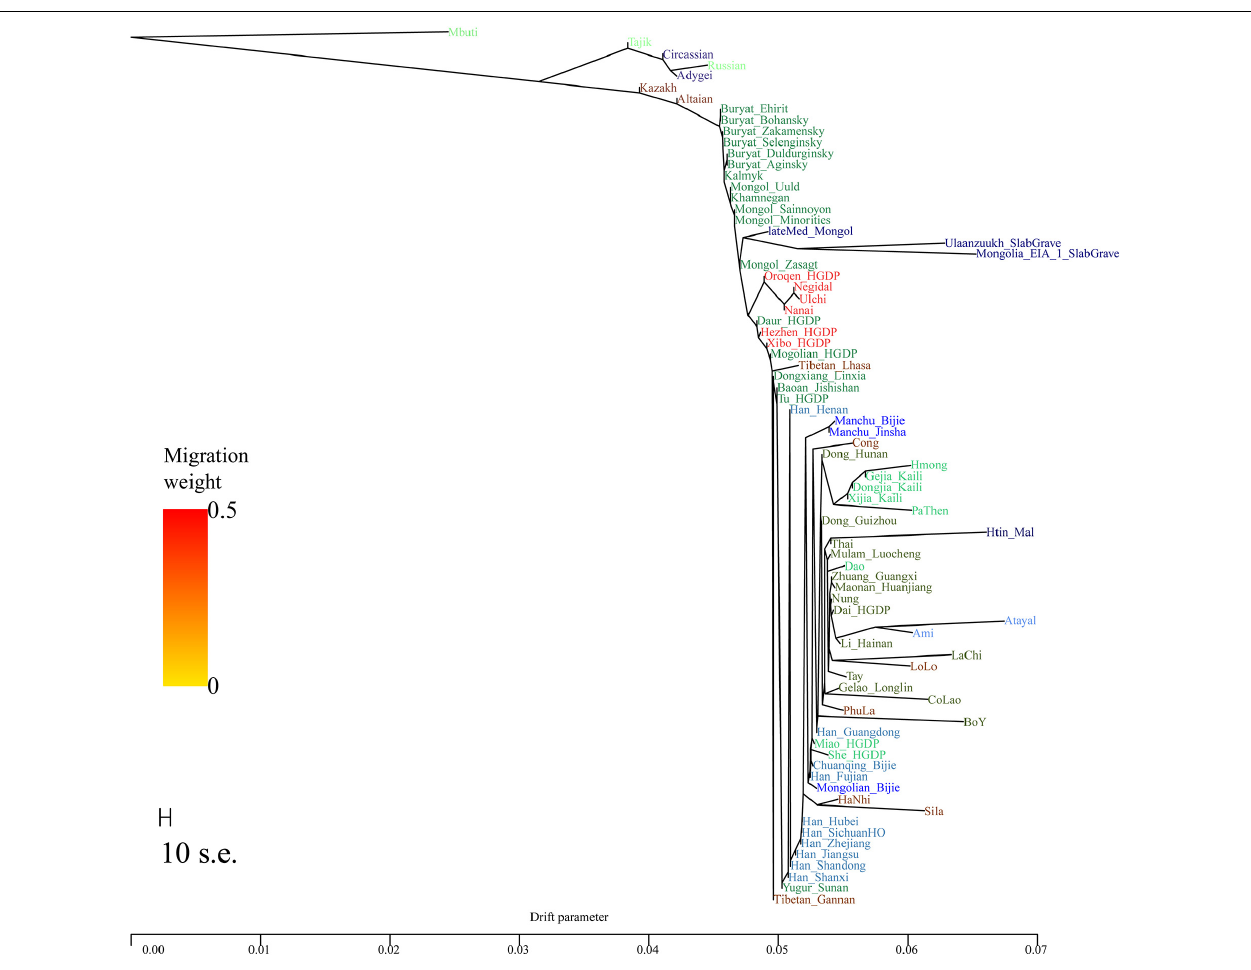
FIGURE 4 | Phylogenetic relationship among northern Altaic, central Sino-Tibetan and southern Austronesian, Austroasiatic, Hmong-Mien, and Tai-Kadai speakers. Mbuti population from central Africa were set as the root. Different populations were marked according to their linguistic affinity.